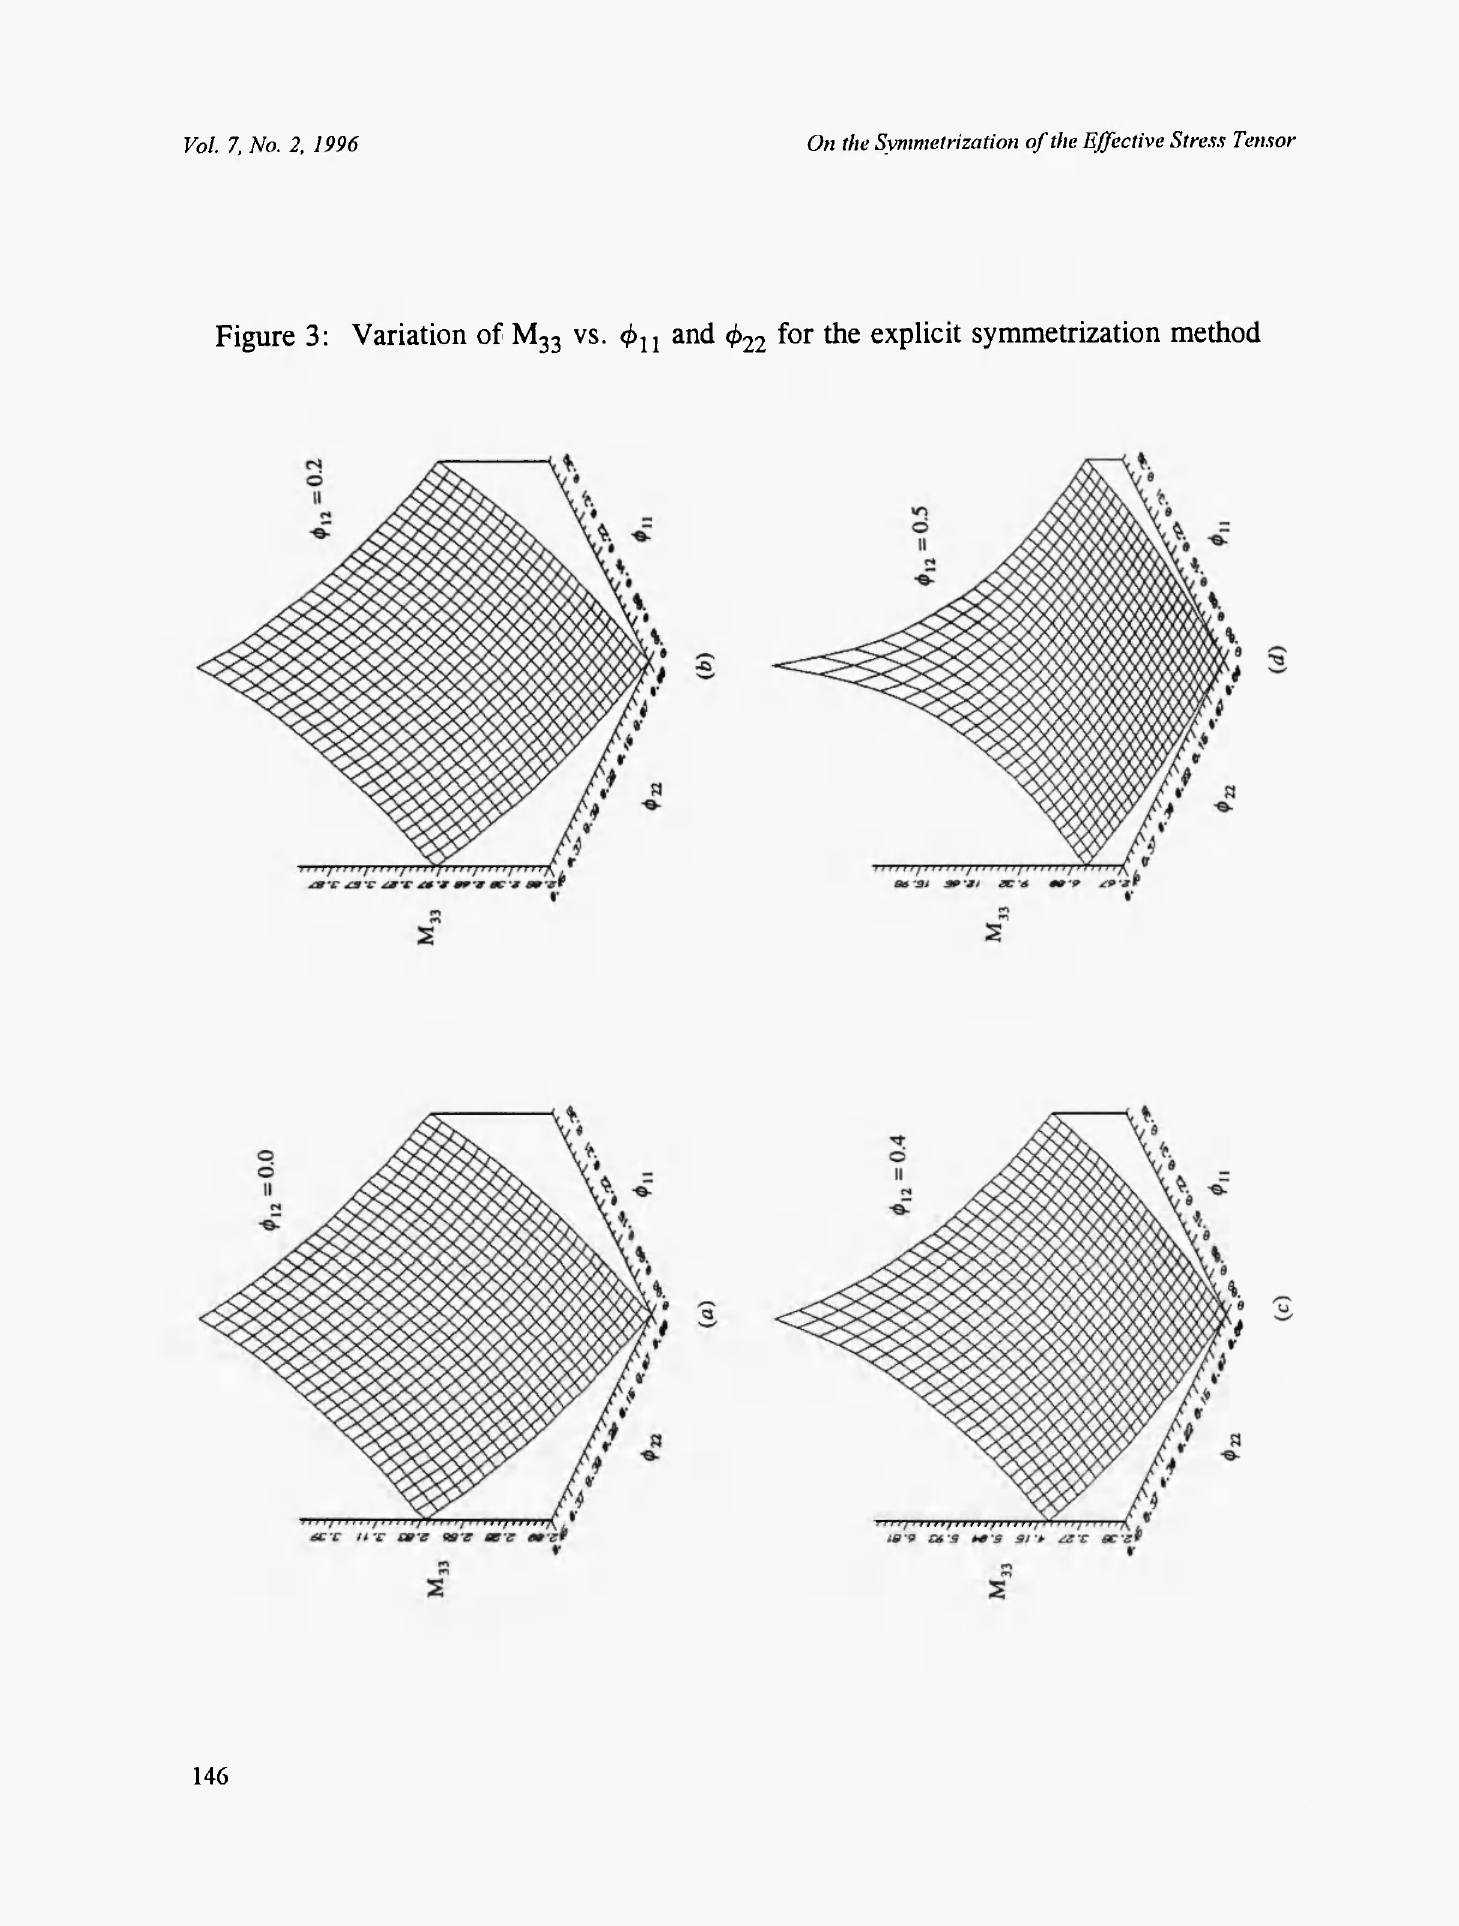
Figure 3: Variation of M